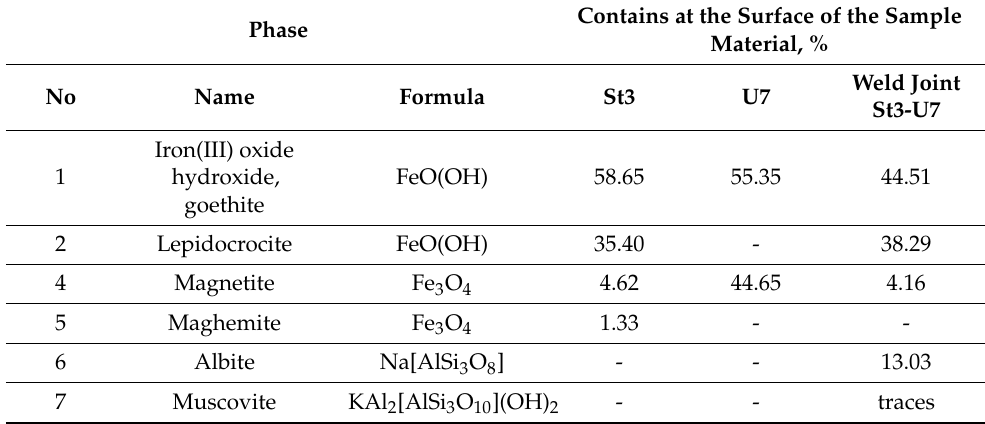
Figure 11. Diffractogram of the weld joint St3-U7 surface compounds. Vertical bars at the bottom of the graph mark the peak positions of the identified phases. Table 4. Summary data on the study of the phase composition of samples after exposure for 60 days according to the X-ray phase study. Contains at the Surface of the Sample Phase Material,